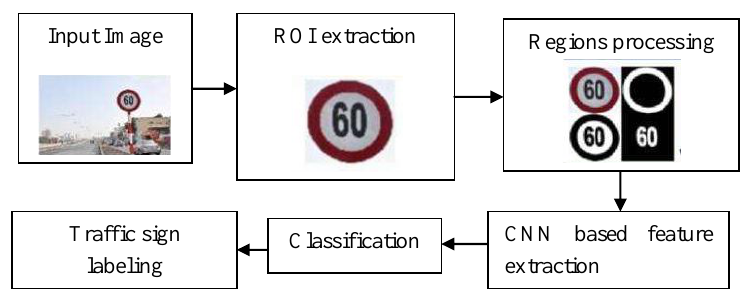
Fig. 4. A n ex.1, showing traffic sign recognition and detection system.